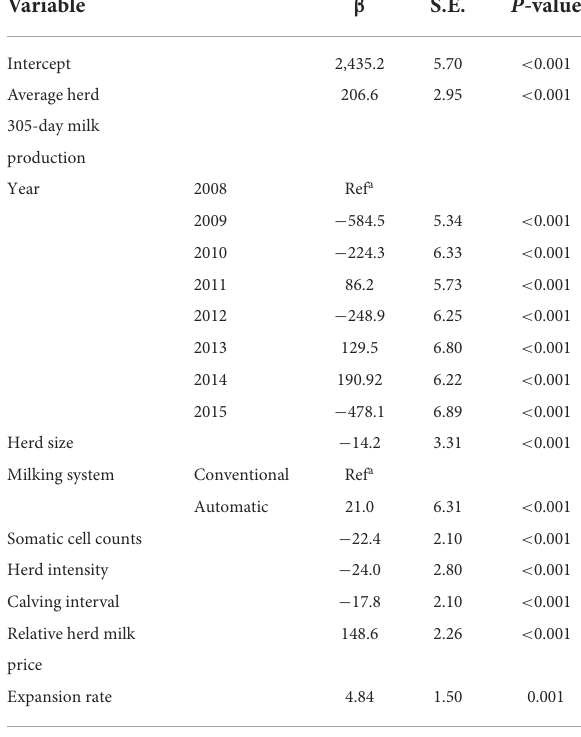
TABLE 4 Results of the final reduced linear mixed model on the association between income over feed cost per cow ( e ) and average herd 305-day milk production (and other herd variables) based on data from 1,664 Dutch